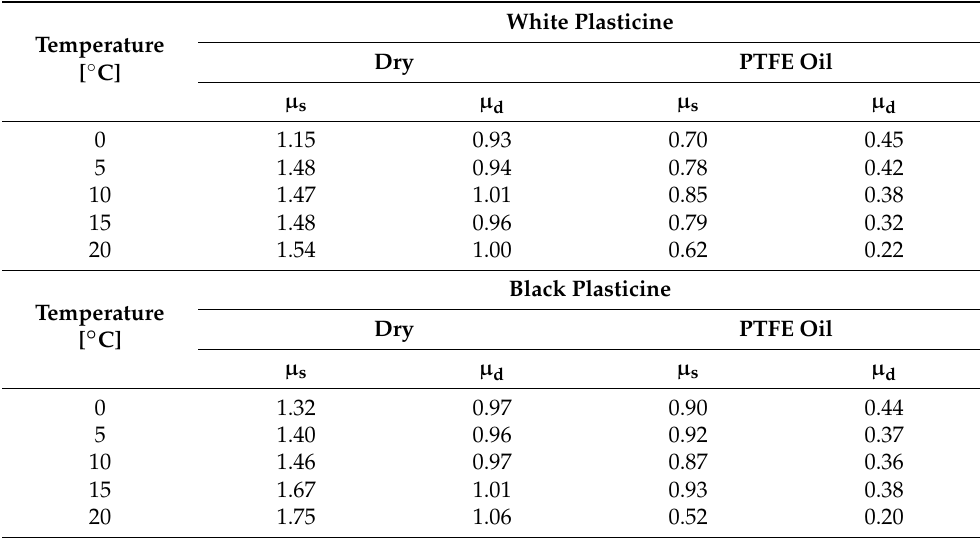
Table 3. Friction coefficient values of the commercial plasticine—ABS tools node